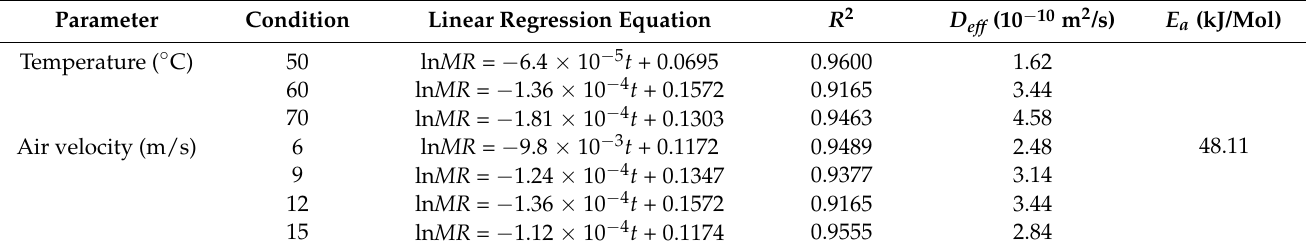
Figure 3. Drying kinetics ( a ) and drying rate ( b ) curves Ophiopogonis Radix under different air velocity. Table 1. Effective moisture diffusion coefficients and activation